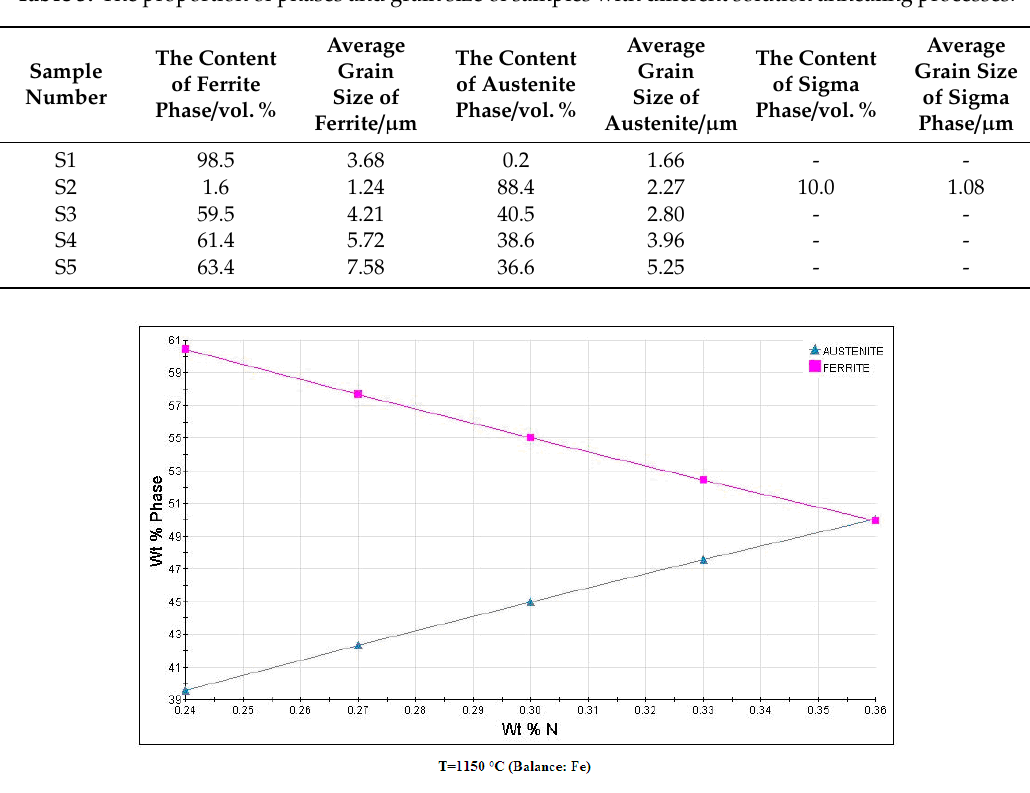
Table 3. The proportion of phases and grain size of samples with different solution annealing processes.